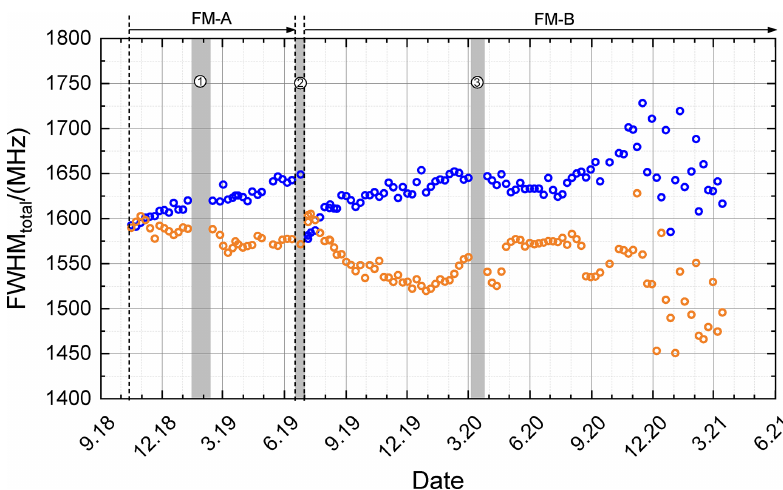
Figure 9. Total FWHM of the direct channel (blue circles) and the reflected channel (orange circles), derived by fitting Eqs. (9) and (11) to the ISR data sets obtained from 10 October 2018 until 15 March 2021 (see also Table 2) and calculated according to Eq. (12). Special time periods are indicated by gray bars (1: instrument shut off due to a GPS reboot anomaly; 2: switch from FM-A to FM-B; 3: laser CPT optimization).